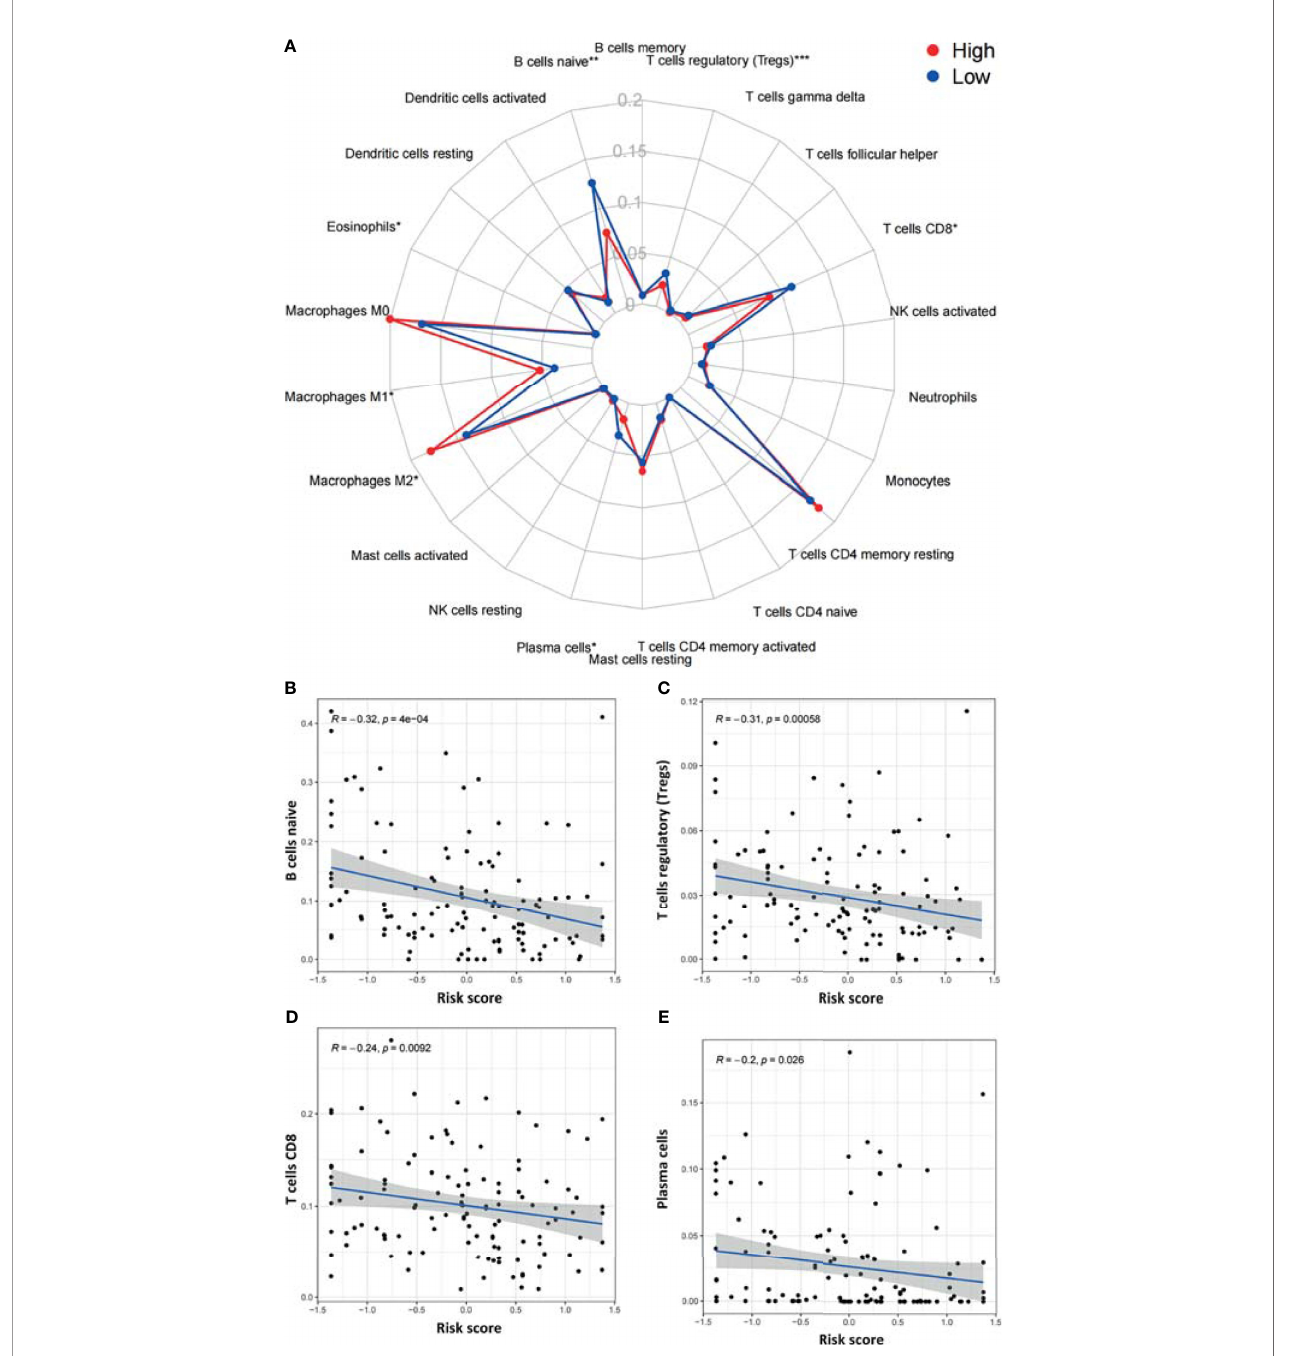
FIGURE 8 | Correlations between the ARGP-based model and the in fi ltration of immune cells determined by CIBERSORT. (A) Differences in the in fi ltration of immune cells between the high ‐ and low ‐ risk groups. (B – E) Correlations between the risk score and immune cells were further examined by Spearman correlation analysis, and results with signi fi cant differences are shown (*p < 0.05, **p < 0.01, and ***p <